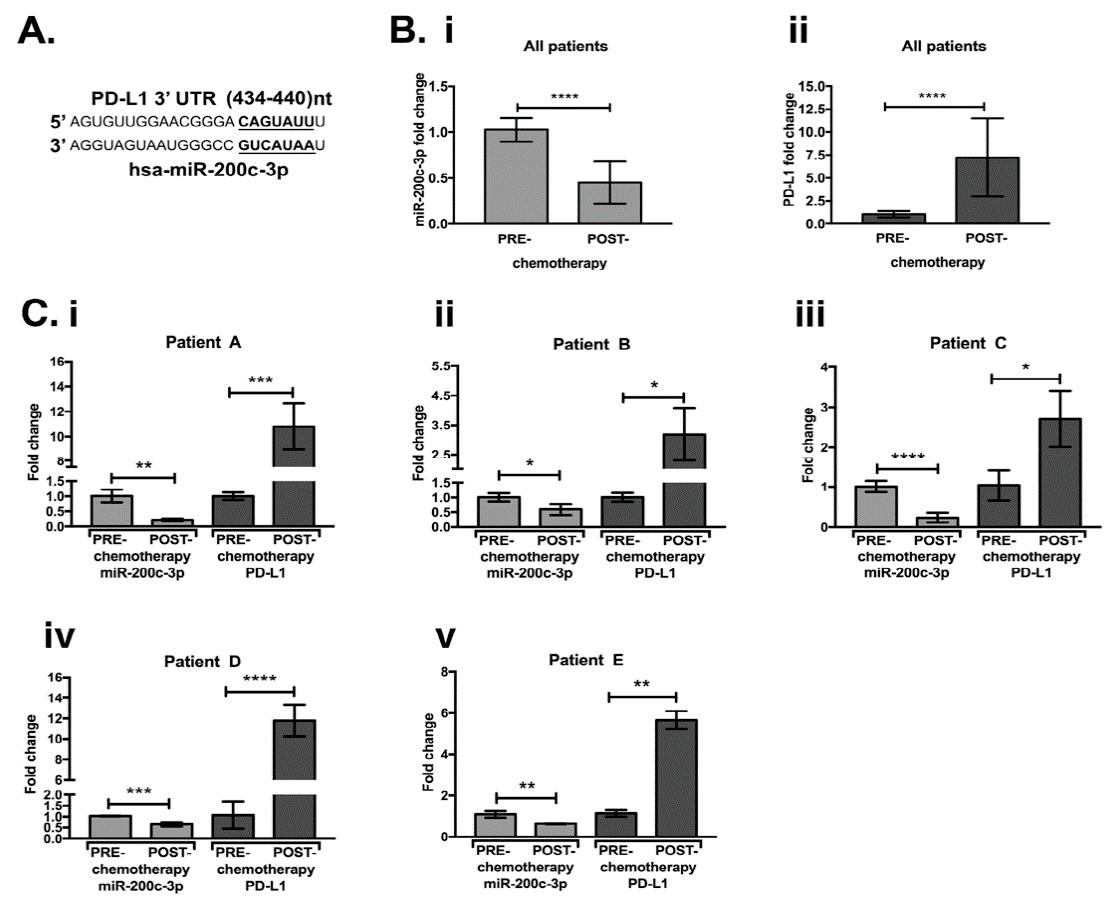
Figure 1. MiR-200c-3p and PD-L1 expression by RT-qPCR are inversely correlated in a cohort of OC patients’ biopsies. ( A ): TargetScan v7.1. prediction of miR-200c-3p seed sequence, highlighted in bold letters and underlined, complements the 3 ′ UTR of PD-L1, from 434 to 440 nucleotides (nt). ( B ) ( i ): miR-200c-3p and ( ii ) PD-L1 expression in a pool of five OC laparoscopic biopsies before and after chemotherapy. ( C ) ( i – v ): miR-200c-3p and PD-L1 expression analysis in the OC biopsies, comparing pre-chemotherapy to post-chemotherapy treatment in each patient (A–E). Fold change was calculated as the average of miR-200c-3p and PD-L1 expression from all five OC patients. miR-200-3p and PD-L1 fold change expression, was normalized by the housekeeping genes RNU6 and GAPDH, respectively. Fold change of miR-200c and PD-L1 expression was calculated for each OC patient as 2 − ∆∆ Ct , considering the difference of Ct ( ∆ Ct) mean values for each gene in the pre-chemotherapy biopsies compared to the mean of the Ct values in the post-chemotherapy biopsies. RT-qPCR measurements were repeated at least three times and in technical triplicates. Two-tailed unpaired t-test was applied for statistical significance, * p < 0.05, ** p < 0.01, *** p < 0.001, **** p < 0.0001.